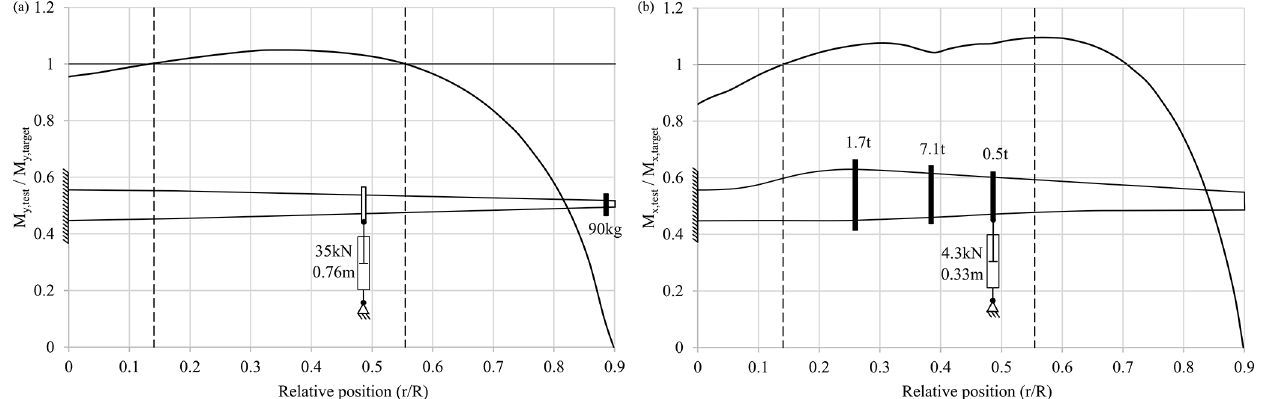
Figure 5. Schematic of uniaxial test setups and test/target load ratio in flapwise (a) and lead-lag (b) directions.